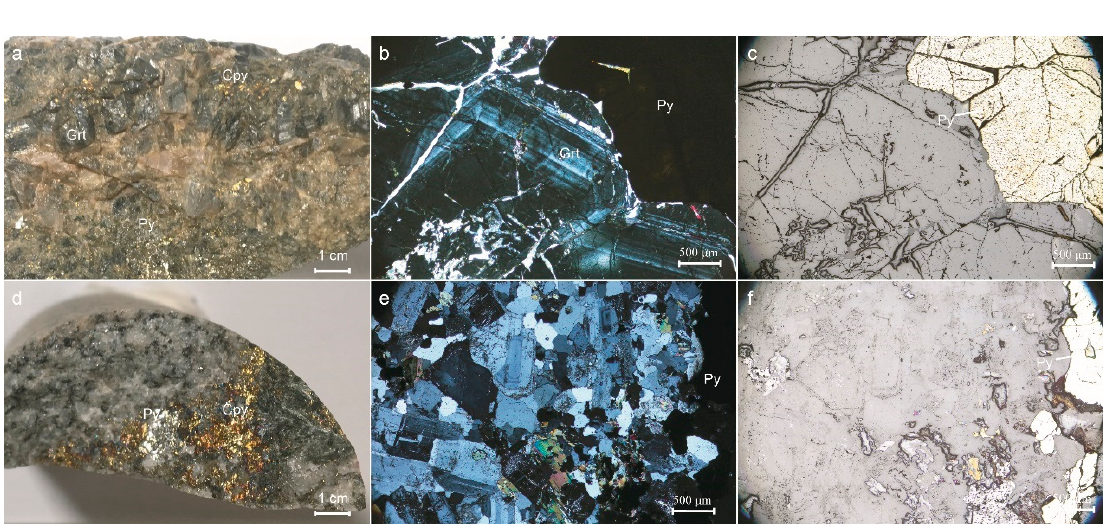
Figure 4. Hand specimens and photomicrographs of samples in the Hucunnan Cu–Mo deposit. ( a ) Hand specimen of pyrite in skarn; ( b ) crossed polars photomicrograph of skarn type; ( c ) reflected light photomicrograph of skarn type; ( d ) hand specimen of pyrite in porphyry; ( e ) crossed polars photomicrograph of porphyry type; ( f ) reflected light photomicrograph of porphyry type. Grt, garnet; Cpy, chalcopyrite; Py, pyrite.